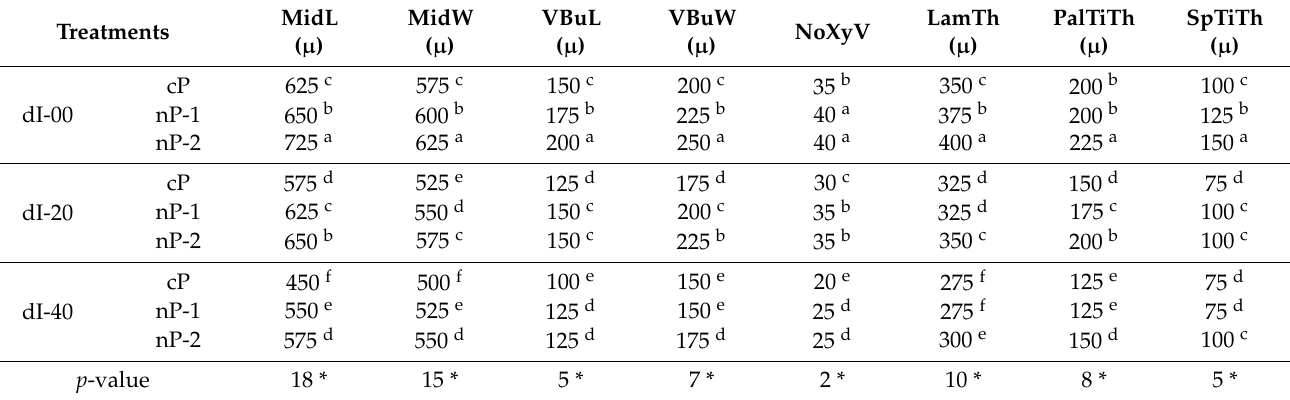
Table 10. Leaf anatomical features of fenugreek plants as affected by different irrigation water regimes and soil and foliar nourishing with phosphorus (P) during the season